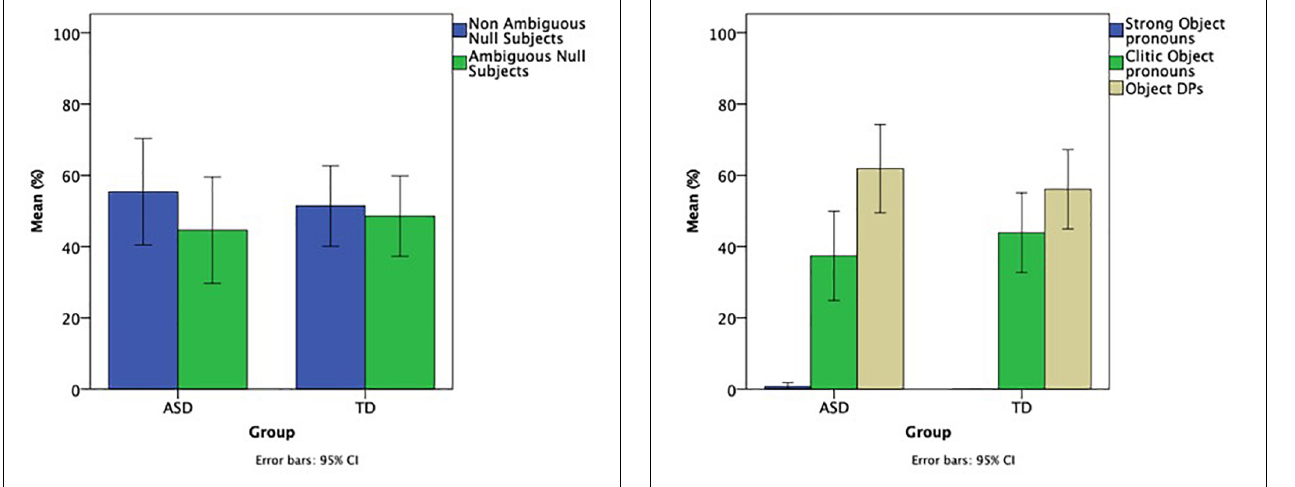
factor, pronoun type (ambiguous, non-ambiguous) as a